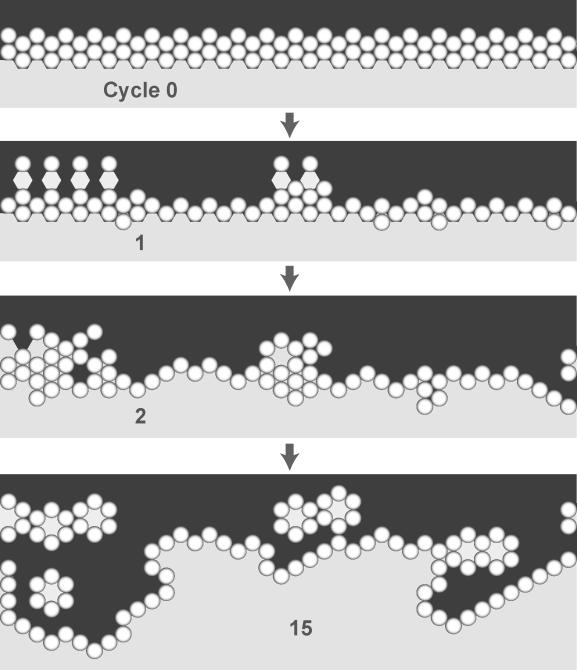
An Invalid Response from Analogue 1The sketched screenshots show the induced growth response of a monolayer of cells in simulated surface culture following placement of a second layer of cells above the first. A black space represents free space or a simulated lumen space; a light shaded space represents matrix. All the cells in a stable monolayer in vitro are polarized and so are expected to be relatively unresponsive to the newly added cells. First, a stable monolayer of cells was formed. The simulation was stopped. A layer of cells was placed on top of the monolayer (top: cycle 0). The simulation was restarted. End of cycle 1: many of the added cells have “died;” growth and development of cells in the original monolayer have been stimulated; encroachment of cells into the matrix below has started. Cycle 2: remodeling is under way. Cycle 15: after considerable remodeling, a stable structure along with several inverted cysts has formed.